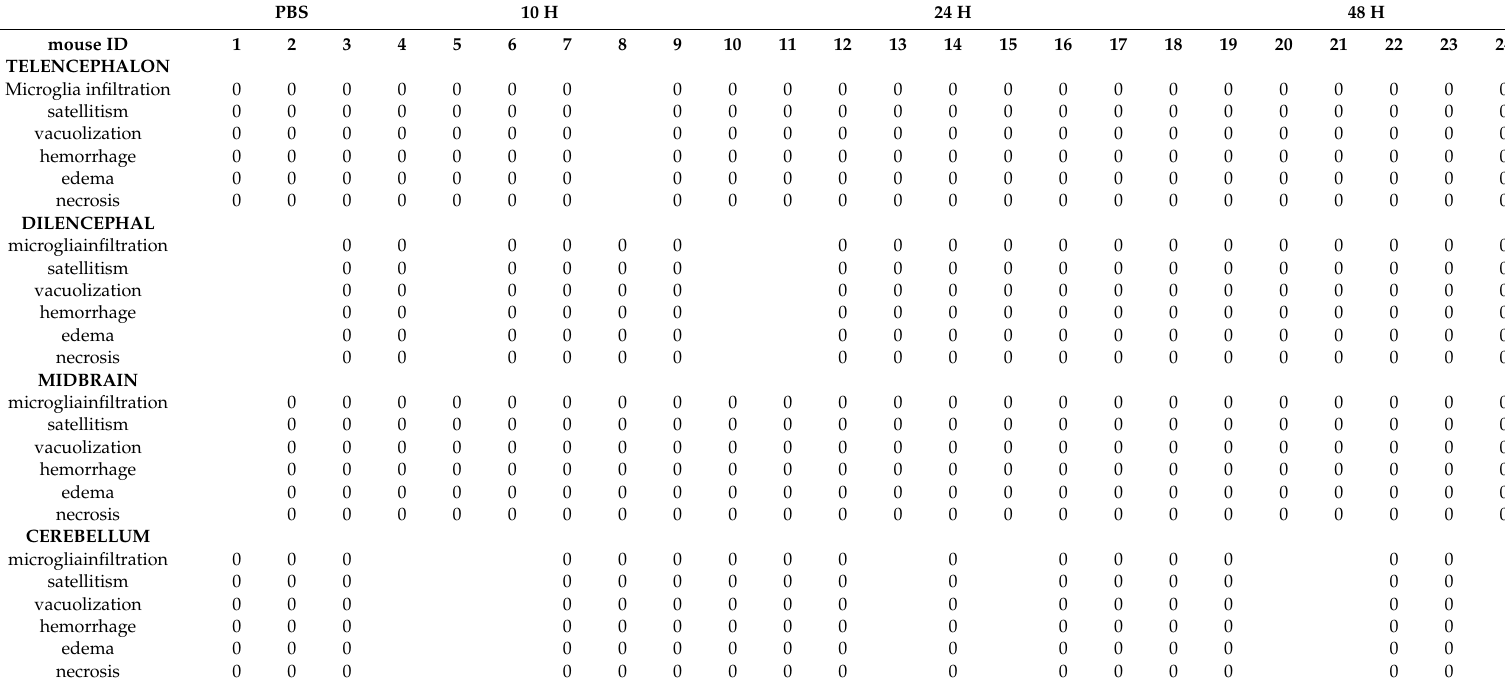
Table 2. Brain toxicity assay of